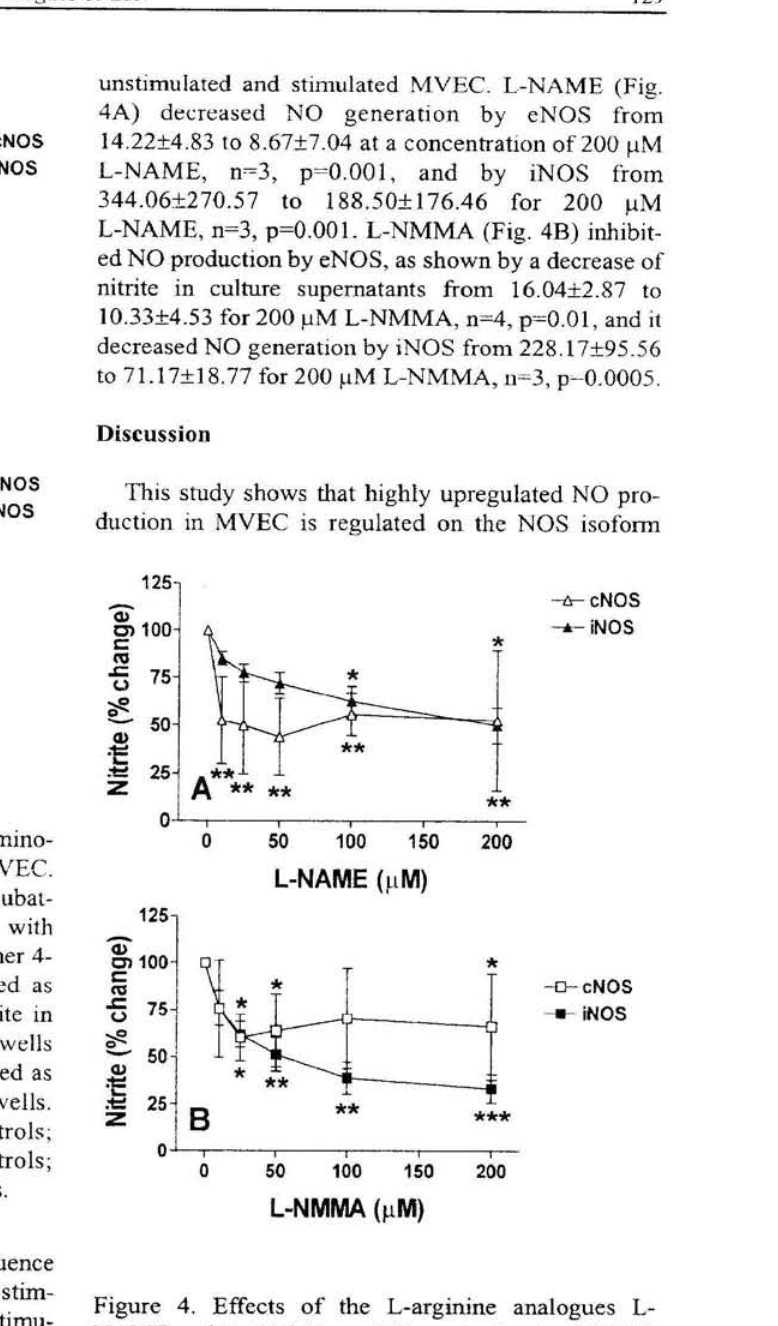
Figure 4. Effects of the L-arginine analogues L- NAME and L-NMMA on NO production by MVEC. Confluent MVEC were incubated without stimulus (open symbols) or treated with IFN-γ (100 U ml 1 ) and LPS (10 μg ml 1 ), and increasing concentrations of either L-NAME (A) or L-NMMA (B) were as indicat- ed. NO production was measured as nitrite in culture supernatants after 48 hours in triplicate wells and duplicate measurements. Results are presented as %